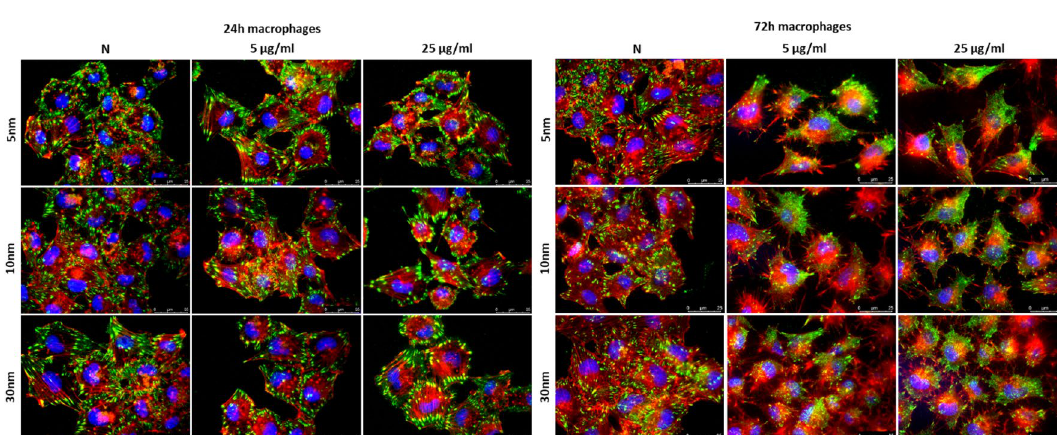
Figure 10. Cytoskeleton architecture of macrophages after 24 and 72-h long of exposure to IONPs with 5 nm, 10 nm and 30 nm core diameters in concentrations of 5 µg Fe/ml and 25 µg Fe/ml compared with control groups (N). The F-actin filaments are stained on red colour, vinculin on green and DNA on blue.